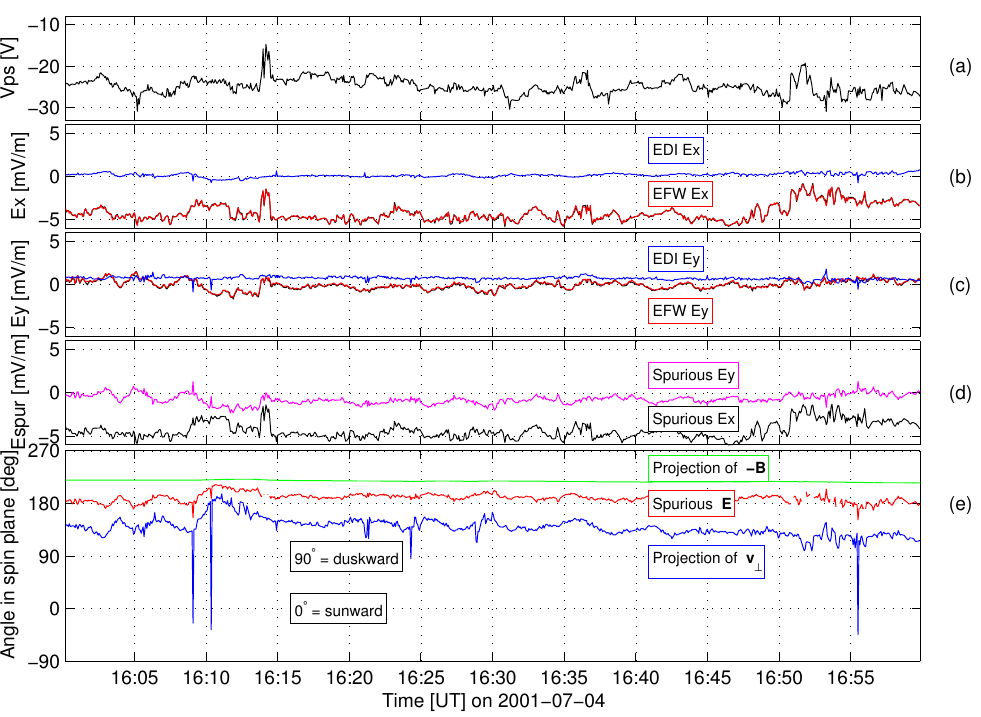
Fig. 9. Comparison of EFW and EDI data for an event with a spurious electric field in the EFW data. Panels from top to bottom: (a) EFW probe-to-spacecraft potential V ps ≈ − V sc . (b) E X (DSI coordinates, see text) in the spacecraft reference frame. Red and black represent EFW data based on spin fits from probe pairs 12 and 34, respectively, blue is EDI. (c) E Y in same format. (d) Spurious field in EFW data, assuming EDI is correct. Black is E X , magenta is E Y . (e) Angles of fields projected onto the spin plane, counted from the Sun direction, as shown in Fig. 10. Red is E spur = E EFW − E EDI , blue is the projection of EDI perpendicular drift velocity, green is the projection of the negative of the geomagnetic field (i.e. the direction along B pointing away from the Earth). The spike-like excursions (e.g. around 16:10 UT) originate from glitches in EDI, which are of no interest here.